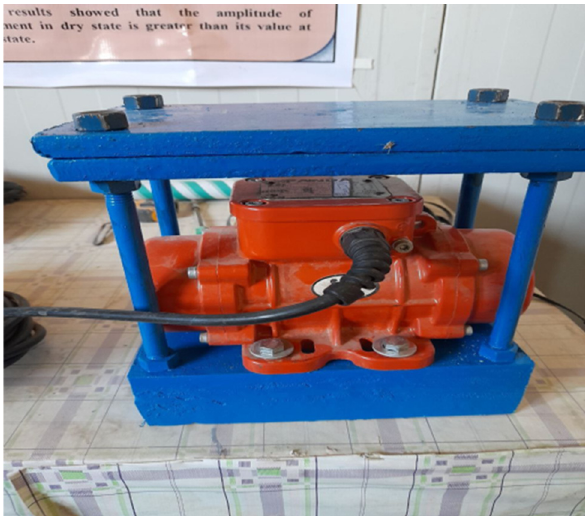
Figure 1: Model of machine and